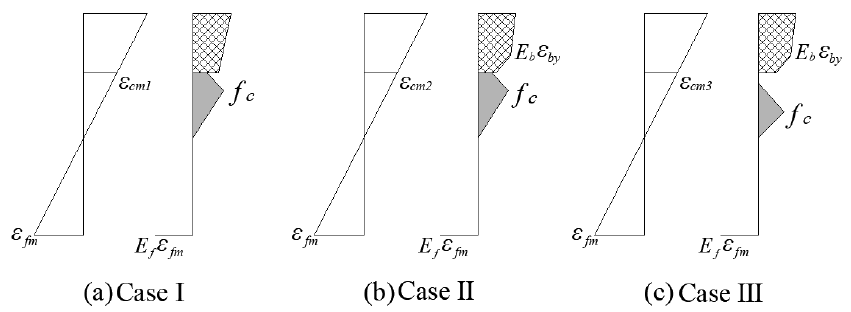
Figure 5. Strain distributions of the cross-section in the CY zone at the peak point A.